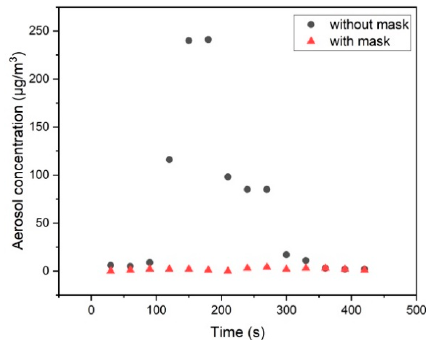
Figure 6. Time-resolved detection of aerosol concentration emitted from the dummy not wearing a mask (black dots) and wearing a surgical mask (red triangles). The distance between dummy and measuring device was d = 0.5 m.